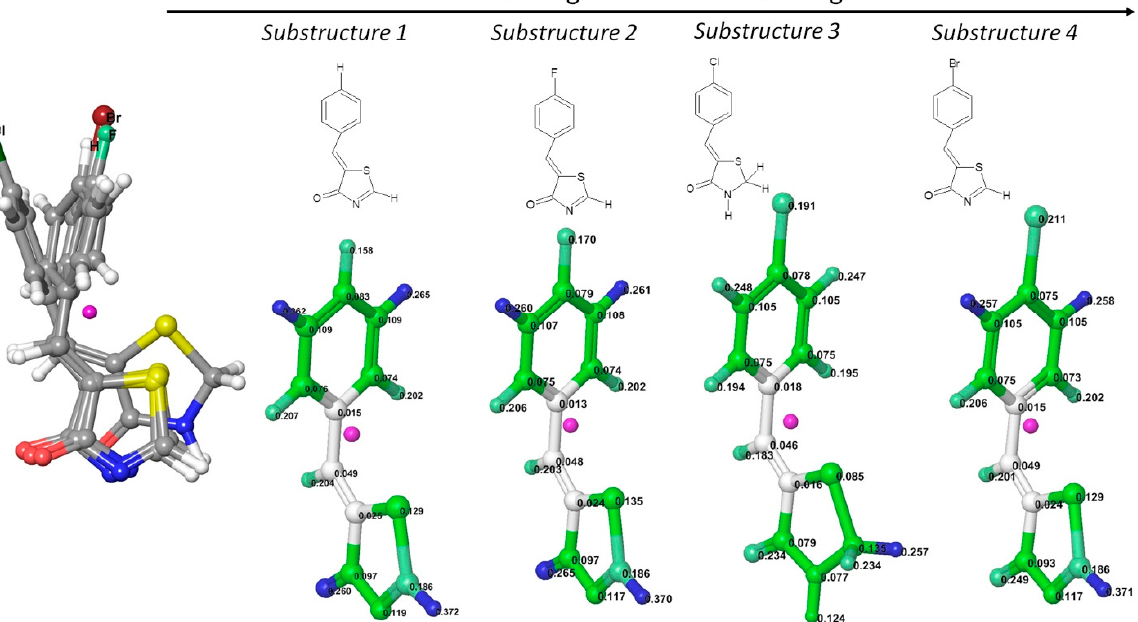
Figure 7. Substructures of compounds Les1, Les2, Les3, and Les4. The geometric center of the molecule is marked pink. Each atom in the molecular structure has a label with a leverage value. Color highlighting indicates atoms with high (blue), medium (green), and low (white) leverage scores.